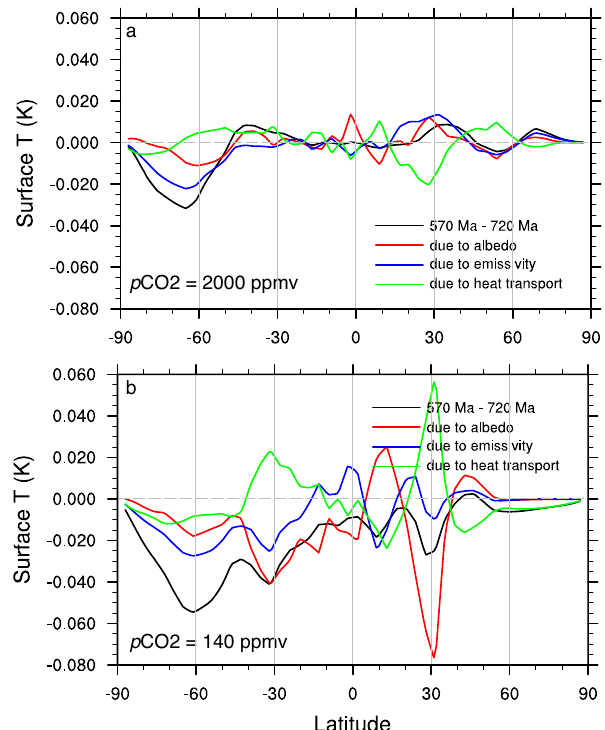
Fig. 9. Difference (100yr mean) in zonal mean surface tempera- ture between the 570Ma and 720Ma climate, weighted by the frac- tion of the surface area of the latitudinal band (width of 1 ◦ ) to the total Earth surface area. TSI = 0.94TSI 0 , τ = 0 . 12 for both pan- els, but the atmospheric CO 2 concentrations are (a) 2000 ppmv and (b) 140ppmv, respectively. The contributions of planetary albedo, emissivity and atm. + ocean heat transport to the difference of sur- face temperature are calculated using a 1-D EBM mdel (e.g., Heine- mann et al., 2009) and are also displayed in the